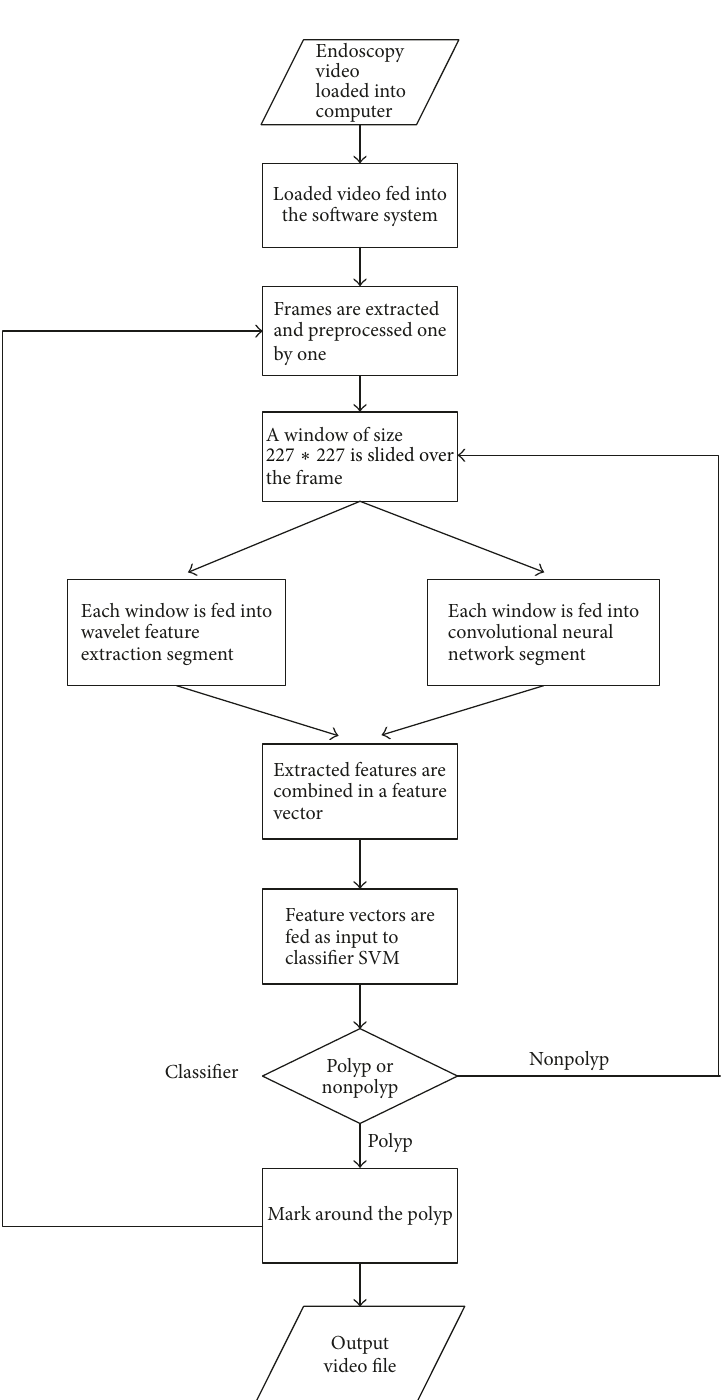
Figure 4: Flow diagram of proposed automatic